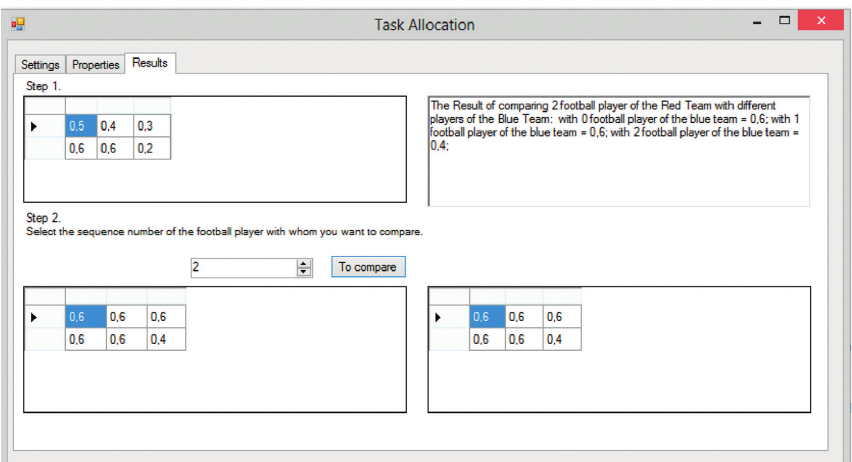
Figure 13: Obtained values of the comparison of the 2nd mobile object of the team of red with the team of blue and the identification of the most successful